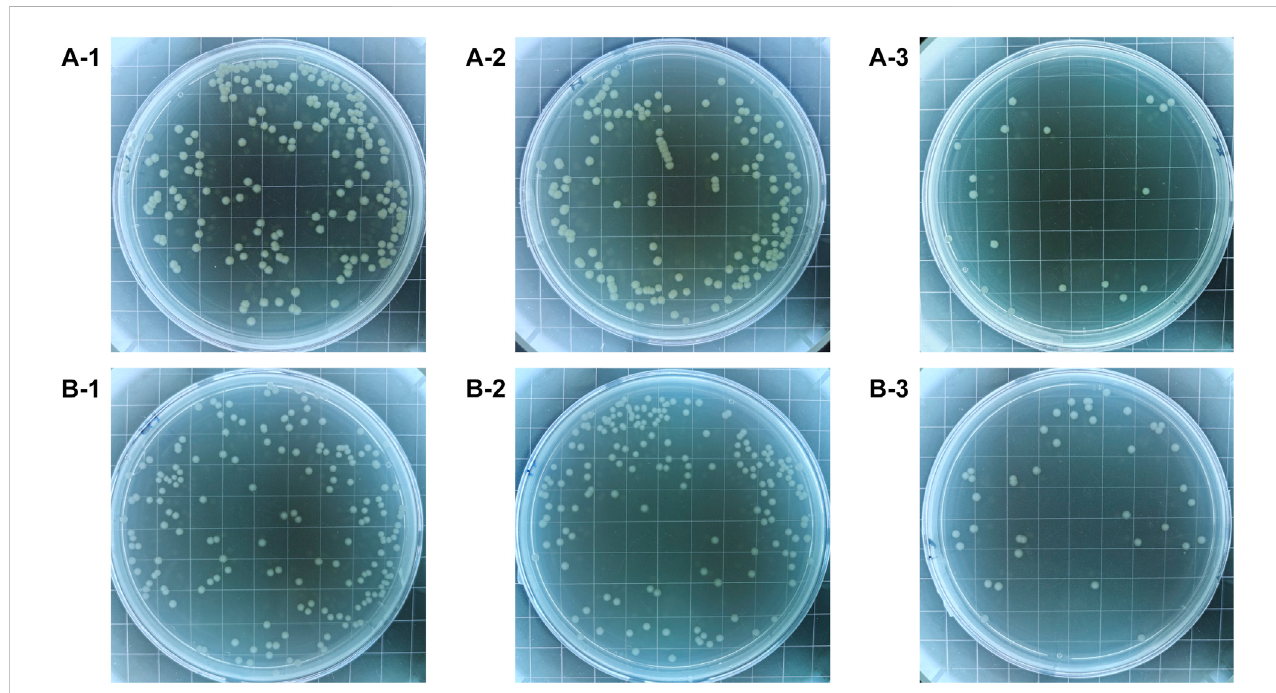
FIGURE 5 Thecolony-formingunitsof E.coli (A) and Bacillus sp. (B) afterincubatedontheAlspecimens(1),Al-COOHspecimens(2),andAl-peptidespecimens(3).